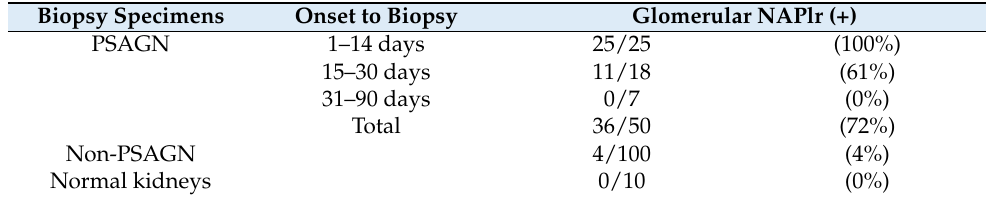
Figure 7. NAPlr localization relative to the glomerular basement membrane. Confocal microscopy images of double immunofluorescence staining for ( A ) α 3 chain of collagen IV (FITC), ( B ) NAPlr (Alexa Fluor 594), and ( C ) the merged image in a post-streptococcal acute glomerulonephritis patient. NAPlr immunofluorescence is mostly seen on the inner side of glomerular tufts. Original magnifica- tion: × 400. NAPlr: nephritis-associated plasmin receptor. Photographs are cited from a previously published report [6], where details of all the staining methods have been described. Table 2. Glomerular NAPlr positivity in PSAGN, non-PSAGN, and normal